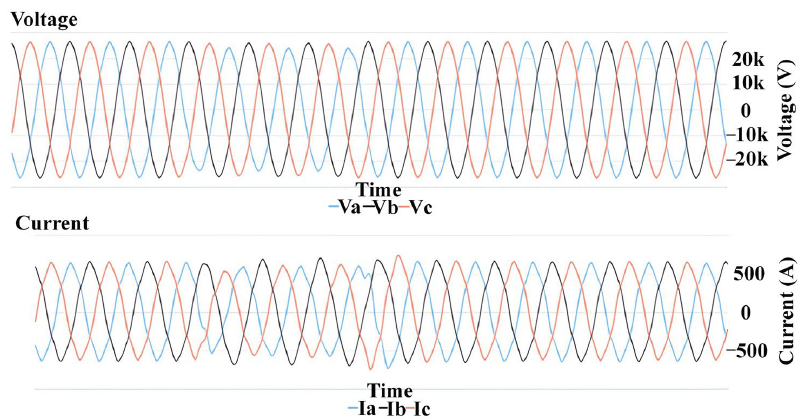
Figure A7. Current and voltage waveform recorded by PQ analyzer during the voltage sag for event 7.